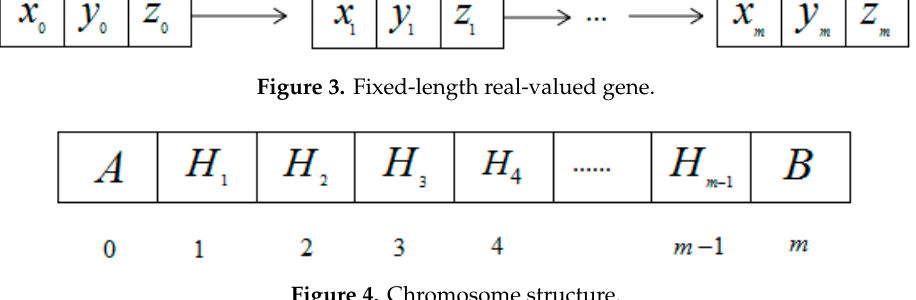
Figure 4. Chromosome structure.